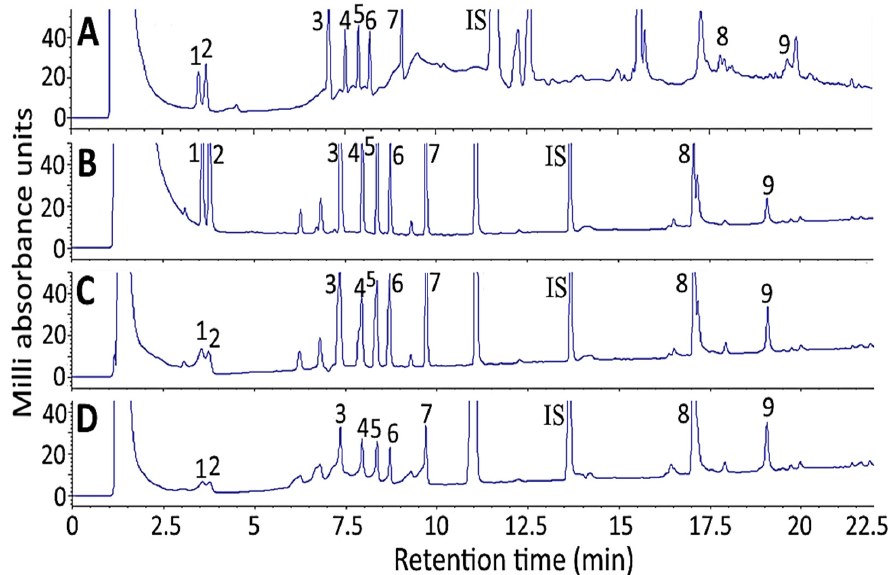
Figure 3. Effect of sample solvent on separation efficiency of 10 ginsenoside standards including internal standard saikosaponin A by HPLC: ( A ) 100% methanol; ( B ) 20% acetonitrile in water; ( C ) 50% acetonitrile in water; ( D ) 80% acetonitrile in water. Separation conditions: column type, Supelco Ascentis Express C18 column; column dimension, 150 × 4.6 mm ID and particle size 2.7 μ m; mobile phase, deionized water and acetonitrile; flow rate, 1 mL/min; column temperature, 50 ° C; detection wavelength, 205 nm. Peaks: 1, Re; 2, Rg1; 3, Rf; 4, Rb1; 5, Rc; 6, Rb2; 7, Rd; IS (internal standard), saikosaponin A; 8, Rg3; 9, CK.